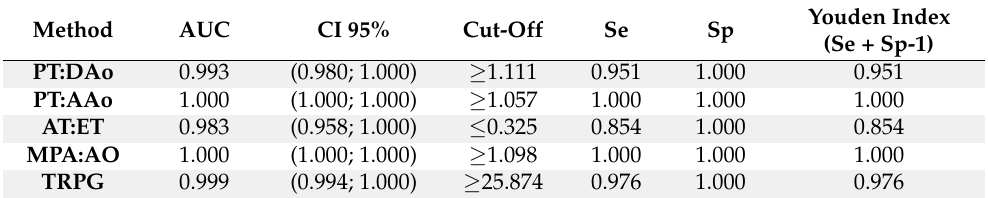
Table 2. Results of simple regression analyses for the prediction of RPAD index.